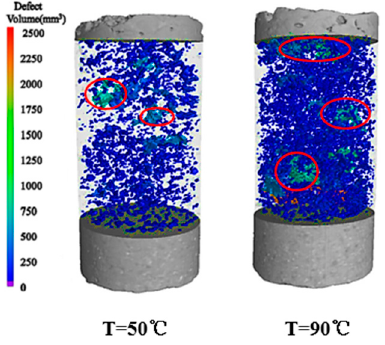
Figure 13. Porosity distribution in shotcrete based on CT image [82].